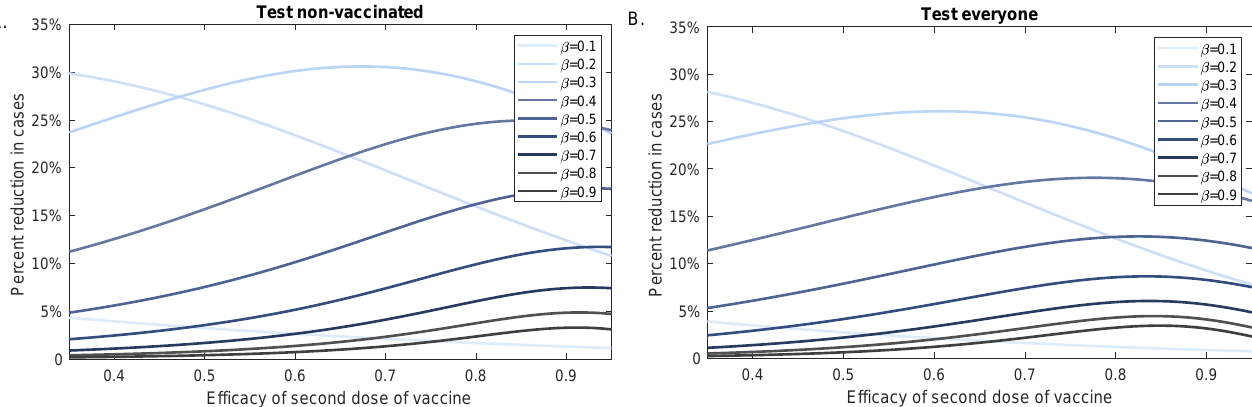
Figure 7. Percent reduction in variant cases at 100 days as vaccination efficacy decreases. Percent reduction in cumulative cases at 100 days after an outbreak with a variants of different infectivity rate β , ( Σ noTests ( 100 ) − Σ Tests ( 100 )) / Σ noTests ( 100 ) , as given by model Equation (1) versus efficacy of the second dose of the vaccine, η 2 . Panel ( A ): Test non-vaccinated only; Panel ( B ): Test everybody. Parameters and initial conditions are given in Table 1, we assume background vaccination V 0 = 0.5 and RT-PCR testing capacity C = 0.1 with a return delay of 1